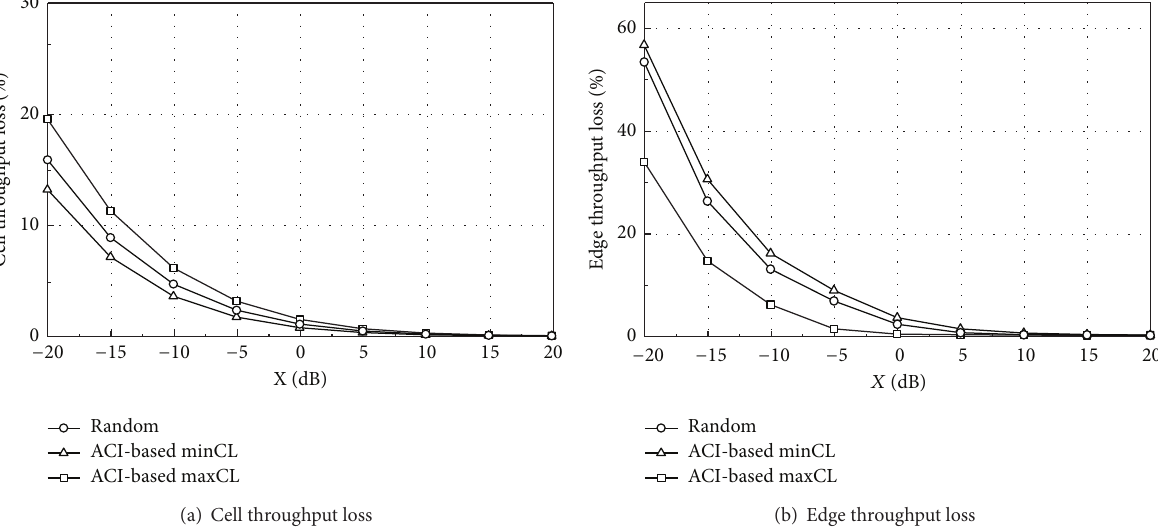
Figure 10: Throughput loss (TPC set 2,